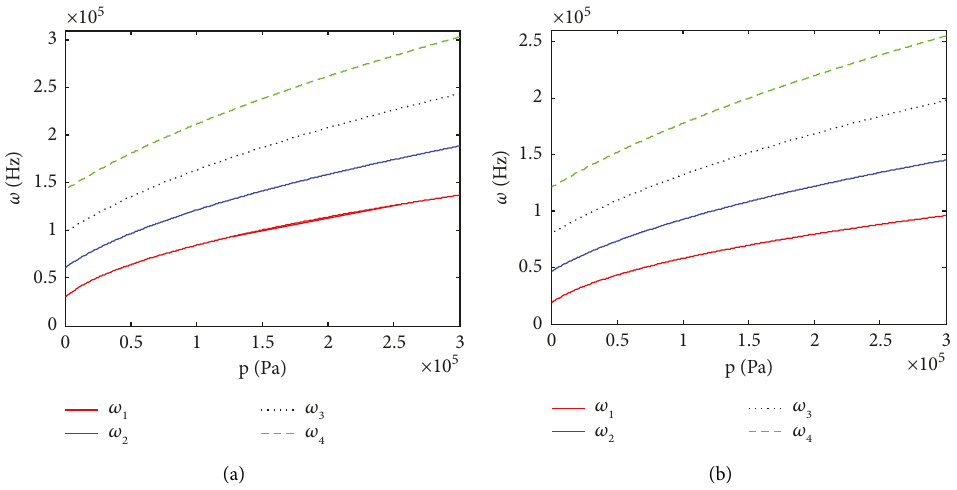
Figure 11: Changes of the resonant frequencies with pressure (a) odd modes (b) even modes.